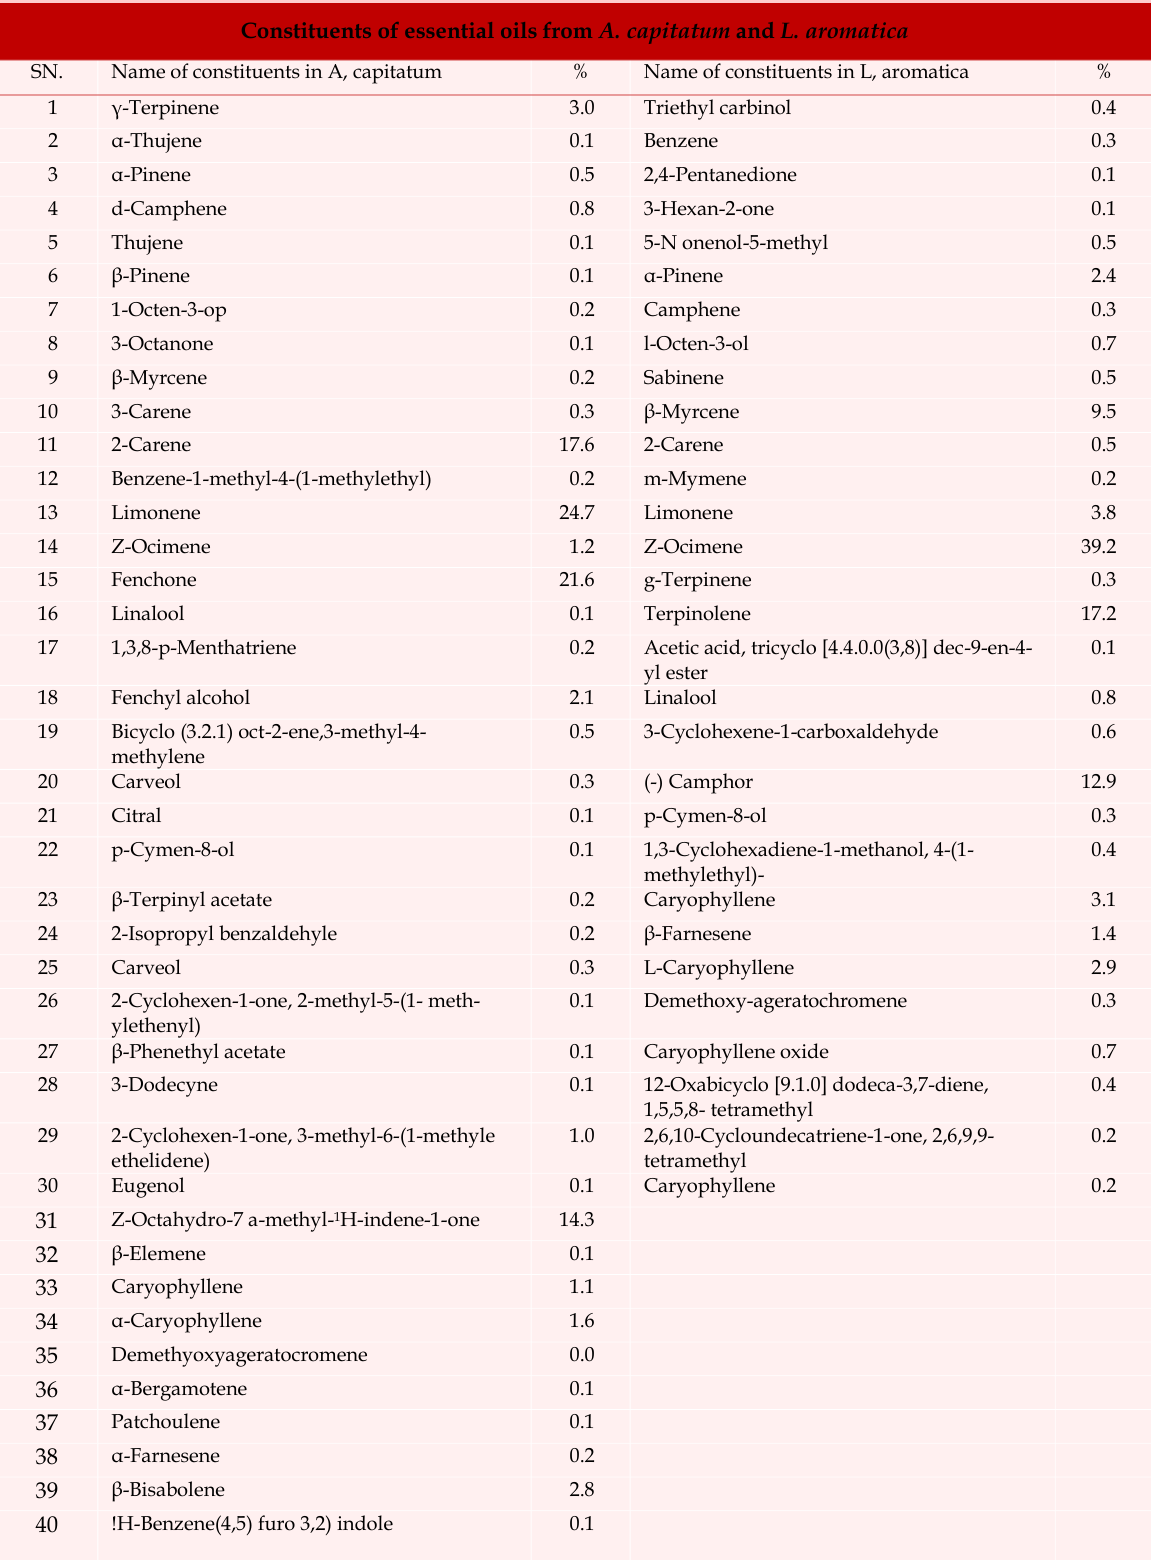
Constituents of essential oils from A. capitatum and L.